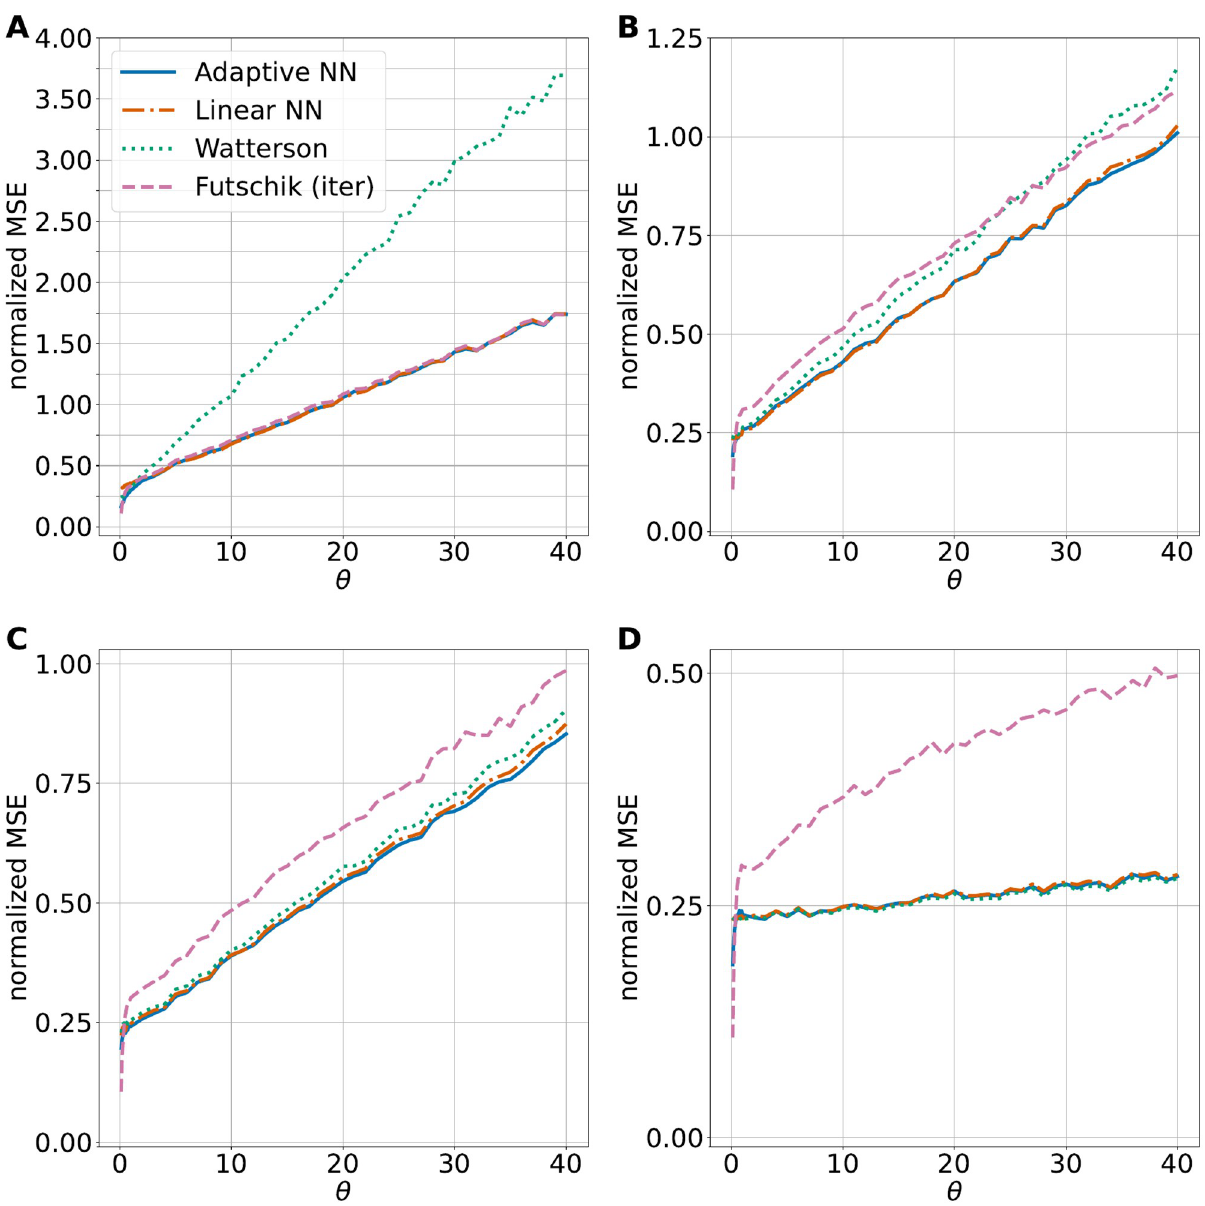
Fig 1. Performance of mutation rate estimators. The normalized MSE for four different estimators are shown: The iterated minimal MSE estimator (Futschik (iter)), Watterson’s estimator, and two neural network estimators. A linear network without a hidden layer and an adaptive network with one hidden layer and 200 hidden nodes. For each subplot, we used msprime to generate a total of 4.9 � 10 5 independent simulations with sample size n = 40, recombination rate ρ , and 49 different mutation rates θ 2 (0, 40]. A: recombination rate ρ = 0, B: ρ = 20, C: ρ = 35, D: ρ = 1000. All shown neural networks have been trained on data sets with the corresponding recombination rate ρ